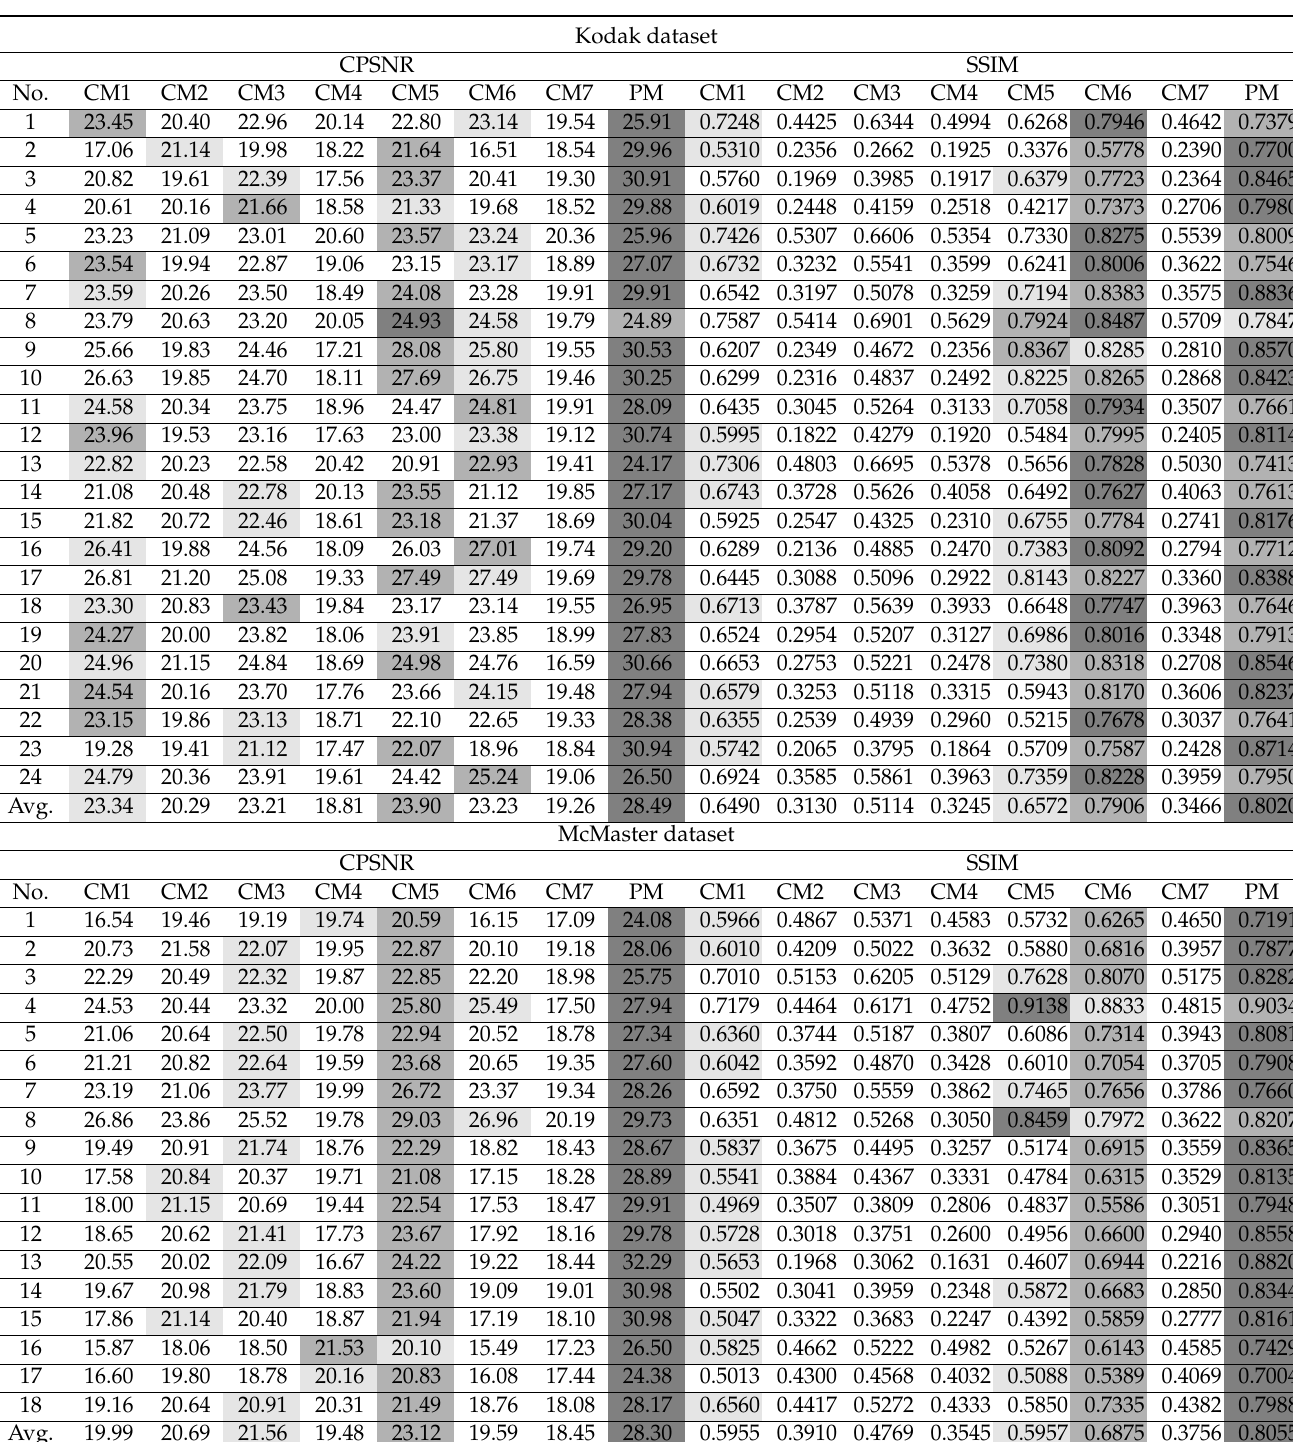
Table 2. Objective Performance Comparison of the Kodak 24 and McMaster 18 Images in CPSNR (dB) and SSIM for Crosstalk Degradation 2 (crosstalk kernel with σ g = 0.6 and noise with σ n =